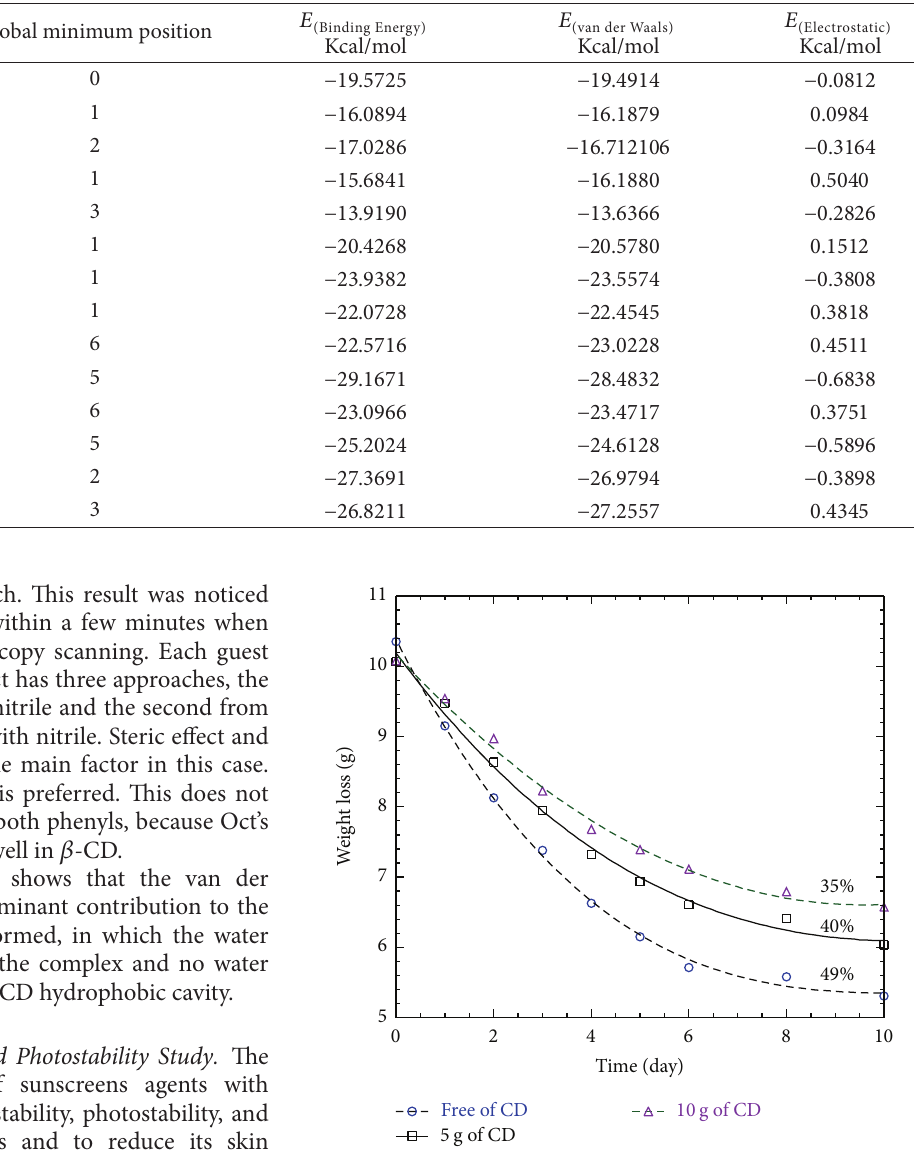
Table 3: Binding, van der Waals, and electrostatic energies with selected components at the minimum binding energy (global) for Oxy, Cin, and Oct through two rims of 𝛽 -CD.